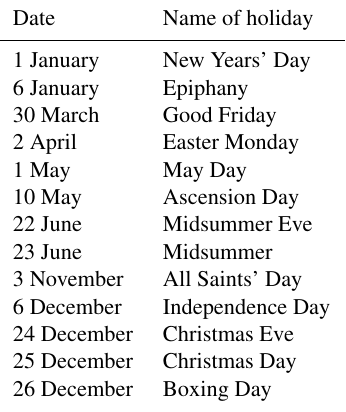
Table 1. Official holidays in Finland, 2018.